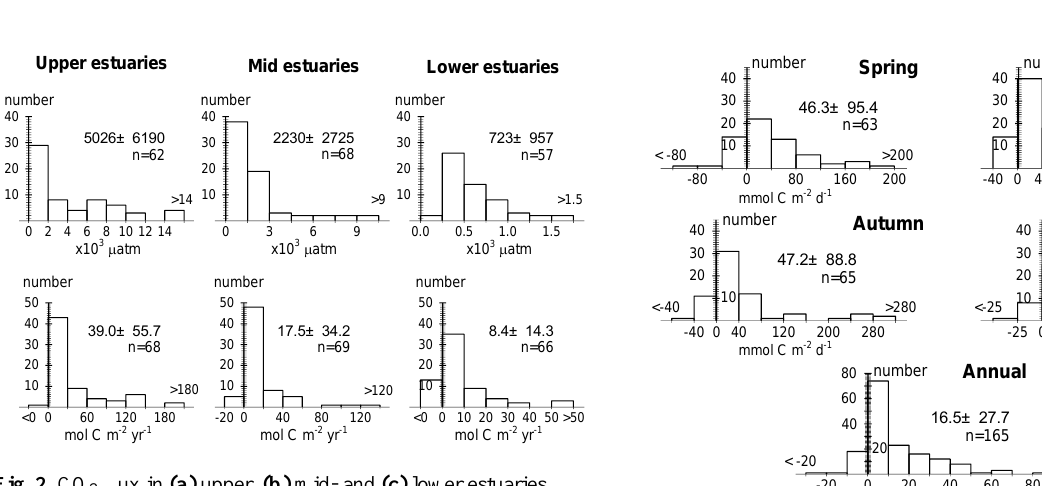
1 Figure 3. Histogram of reported daily CO 2 fluxes per unit area in different seasons and the annual flux of 2 world's estuaries. 3 Fig. 3. Histogram of reported daily CO 2 fluxes per unit area in dif- ferent seasons and the annual flux of the world’s